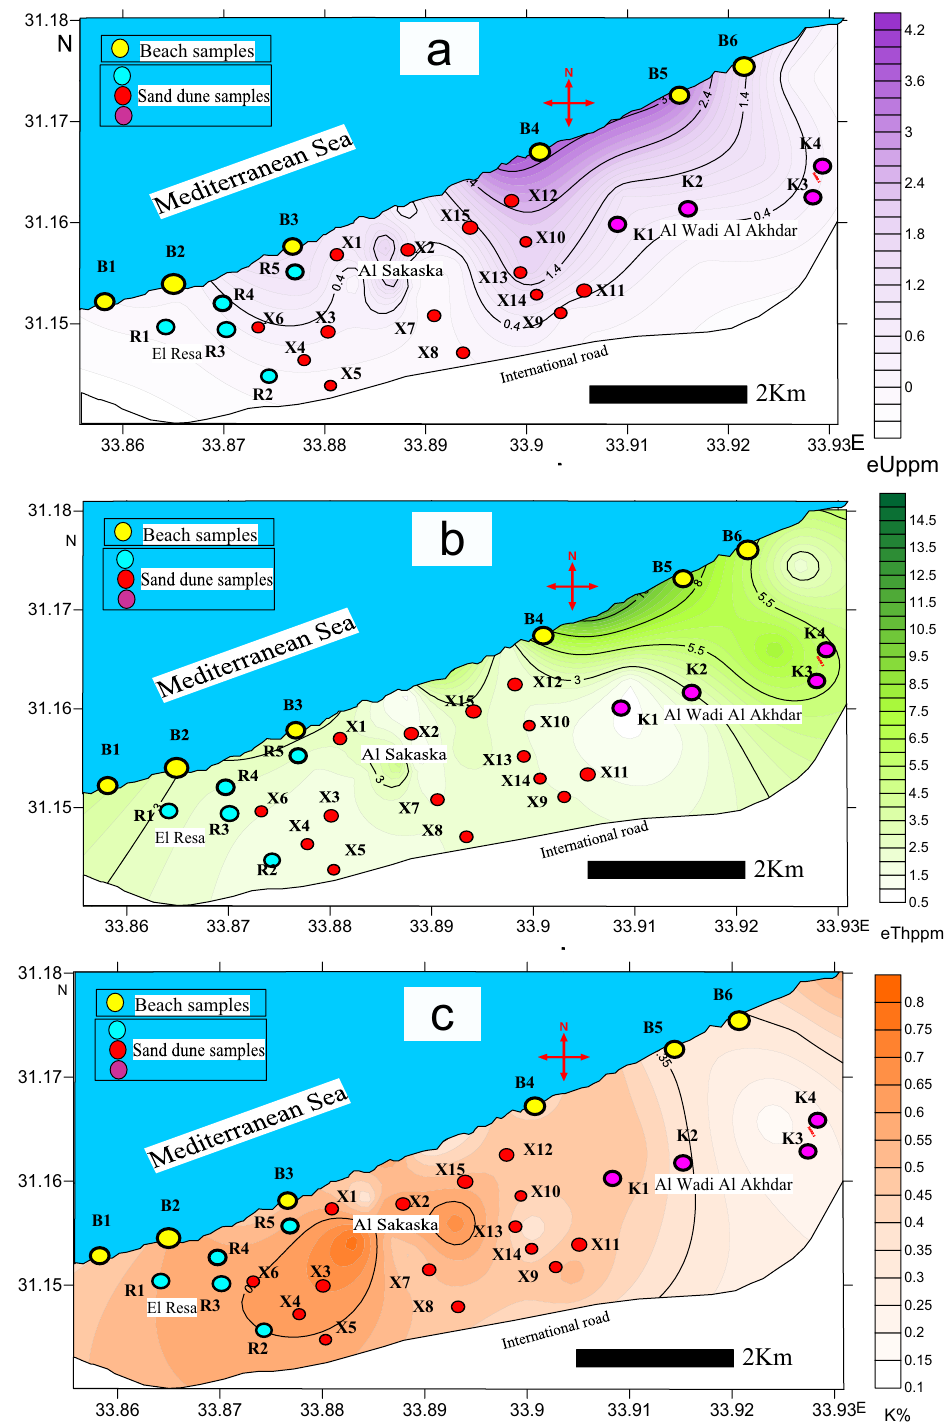
Figure. 8. show: ( a ) eU distribution contour map, ( b ) eTh distribution contour map and ( c ) K % distribution contour map.Map was created by Surfer Software 13.6 (2016) https:// www. golde nsoft ware. com/ produ cts/ surfer.